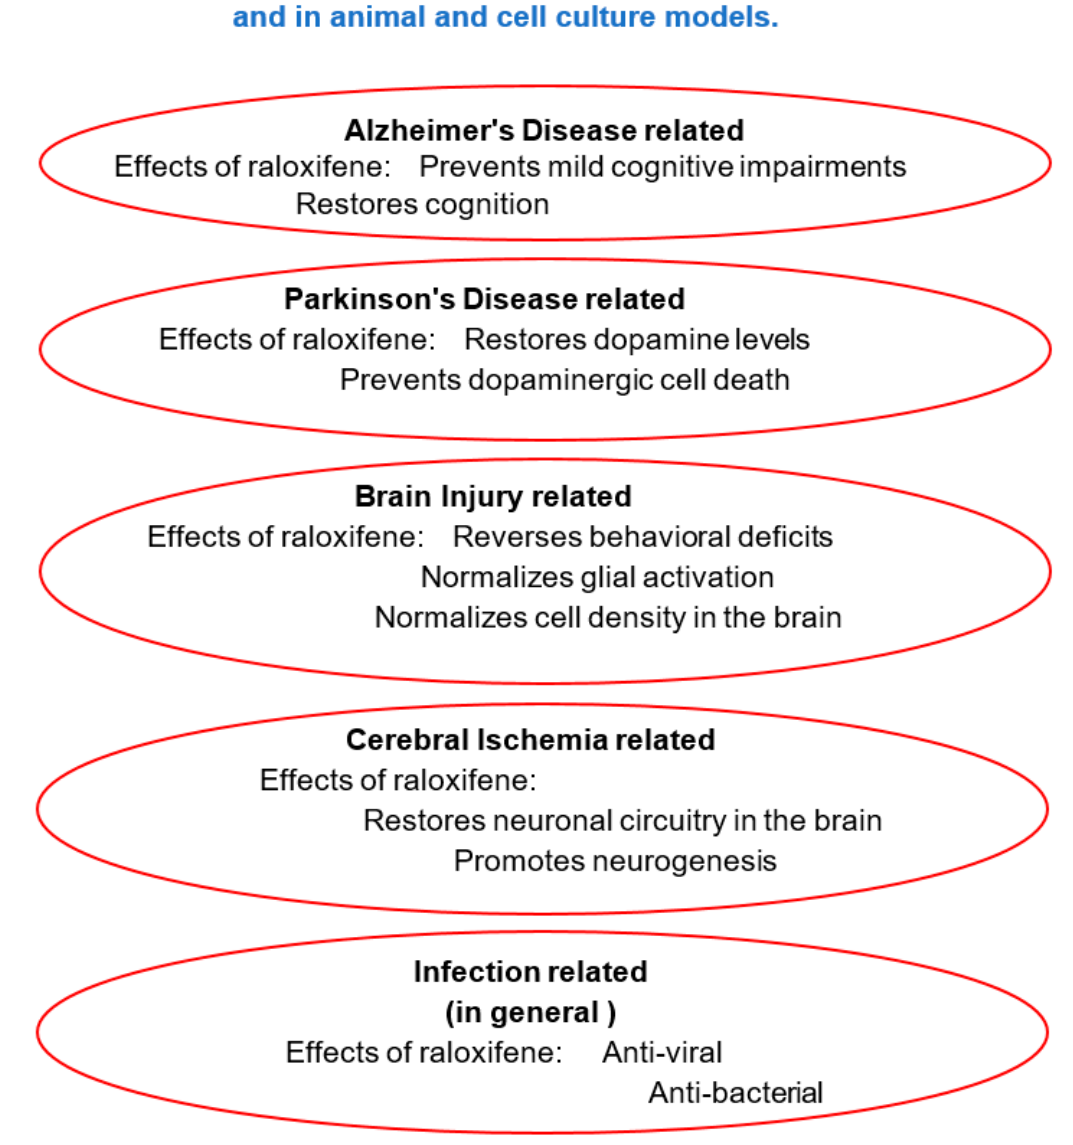
Figure 4. Beneficial effects of raloxifene regarding brain disease and brain injury. Note: each ellipse presents the typical experimental approach applied so far for that model. One can assume that, in principle, most e ff ects seen with raloxifene can occur in each